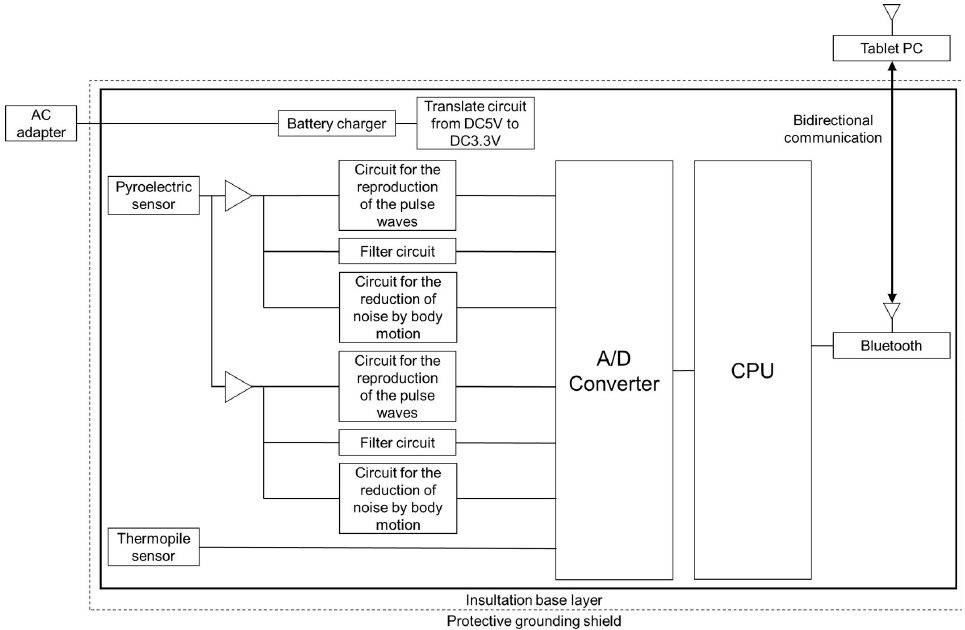
Figure 3. The system block diagram of the steering-type measurement system developed by Arakawa et